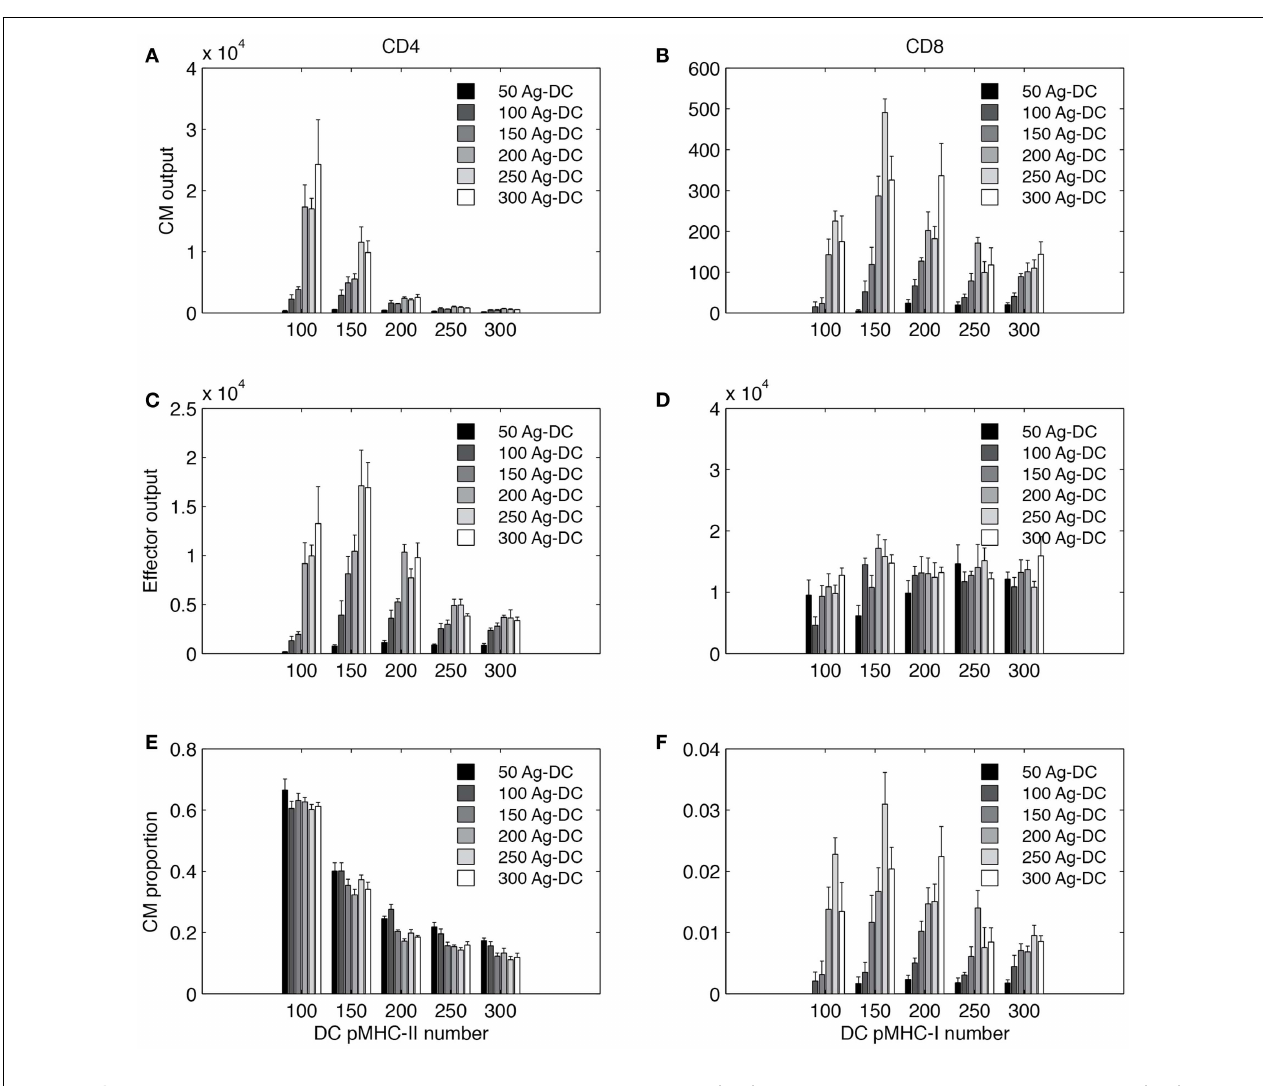
FIGURE 9 | SimulatedT cell differentiation is influenced by number of DCs and number of pMHC molecules displayed . X -axis: number of pMHC molecules on an Ag-DC. Bar color: number of Ag-DCs recruited to